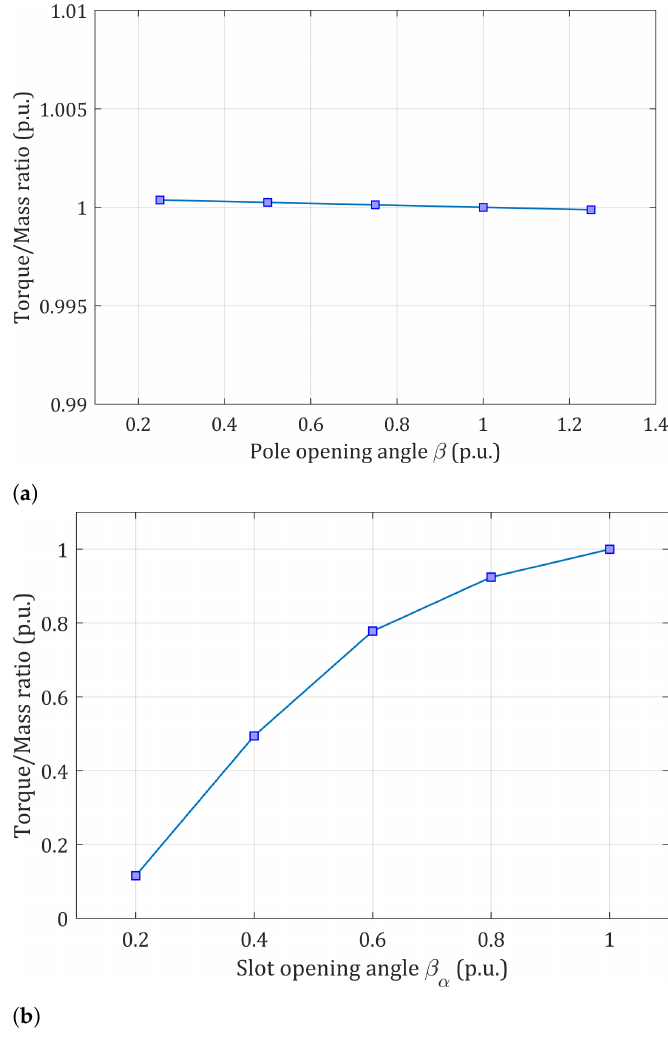
Figure 12. Opening angles impact on the torque density ( a ) pole angle, ( b ) slot